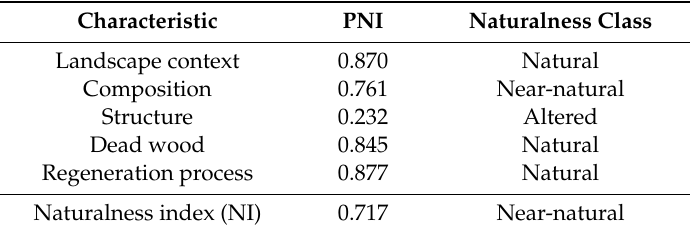
Table 8. Actual (2012) results for the three forest management